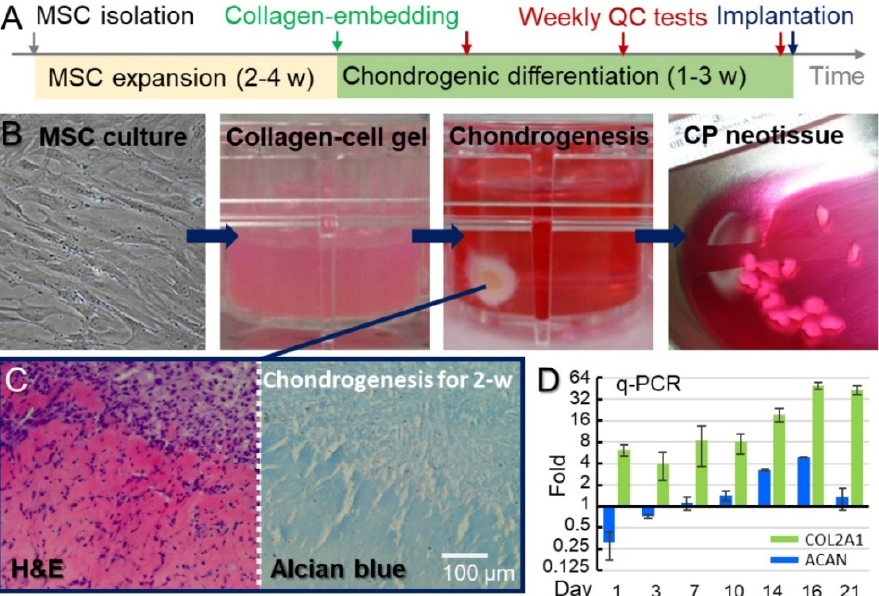
Figure 1. Expansion of MSCs and chondrogenic induction to CPs. ( A ) Generation of the neotissues of CPs: the bone marrow-derived MSCs were expanded through in vitro culture in a GTP lab for 2–4 weeks to obtain enough cells for CP implantation. The MSCs embedded in atelocollagen were induced to undergo chondrogenic differentiation to generate the CPs. During the differentiation, weekly quality control tests, including histological analyses, qPCR, and evaluation for bacterial, endotoxin, and mycoplasma contaminations were conducted to monitor the maturation and safety of cartilage neotissues. The qualified neotissues were then implanted into the patients. ( B ) Images of cells at different stages during the generation of the neotissues of CPs. ( C ) Histological images of neotissues of CPs stained with H&E and Alcian blue demonstrates the abundance of CPs and high GAG levels in the neotissues. ( D ) The mRNAs of two representative biomarkers of hyaline cartilage, COL2A1, and ACAN, were quantified using qPCR. The expression levels were normalized to those of undifferentiated MSCs.